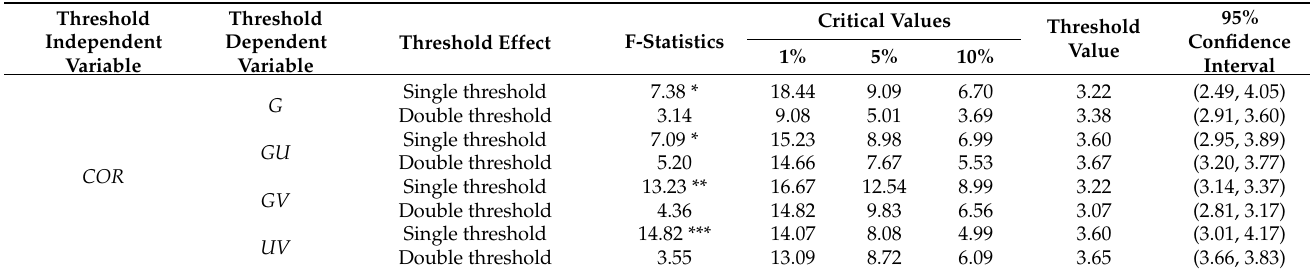
Table 2. Results of threshold effect tests and threshold